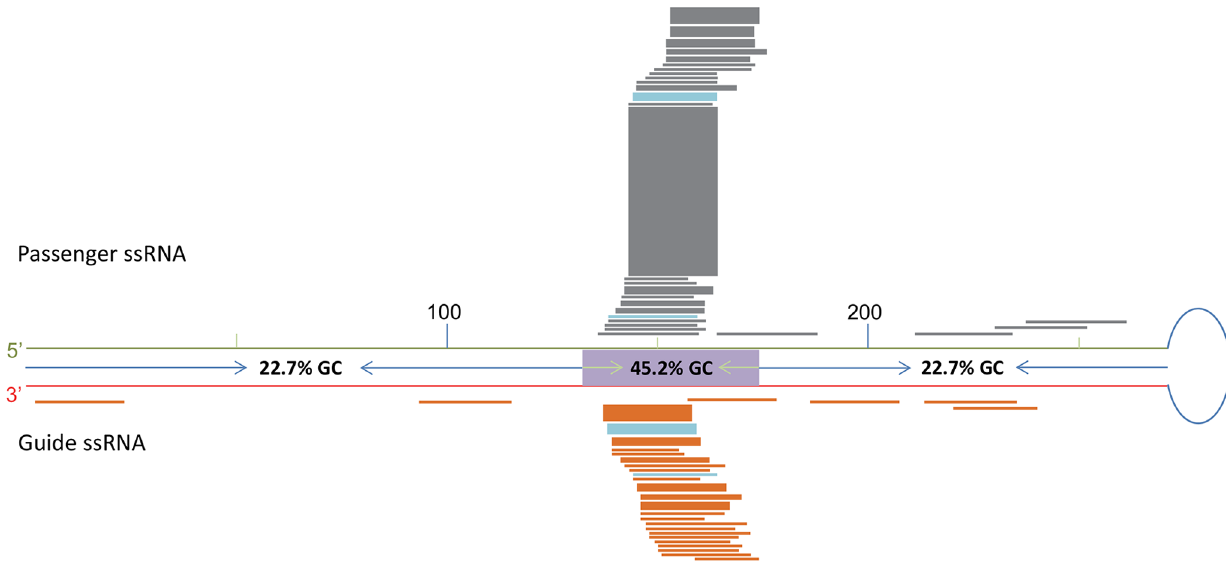
Figure 4. Distribution of the 16D10 small RNAs along the pART27-271 hairpin stem. The schematic hairpin structure of the pART27-271 construct is presented with the green line representing the sense strand, the red line representing the antisense strand, and the blue open circle representing the 39 nt loop. The numbers ‘‘100’’ and ‘‘200’’ along the stem indicate nucleotide positions from the 5 9 stem end. The 16D10 42 bp core coding region is marked as a purple box on the stem. GC content was marked for the stem base region, the middle core region, and loop terminus region. Each small RNA is represented as a block/line, with the thickness of a block/line indicating the relative abundance of a particular small RNA. Passenger and guide ssRNAs were aligned along the sense and antisense strands, respectively. Data for this figure were provided in Table S4.